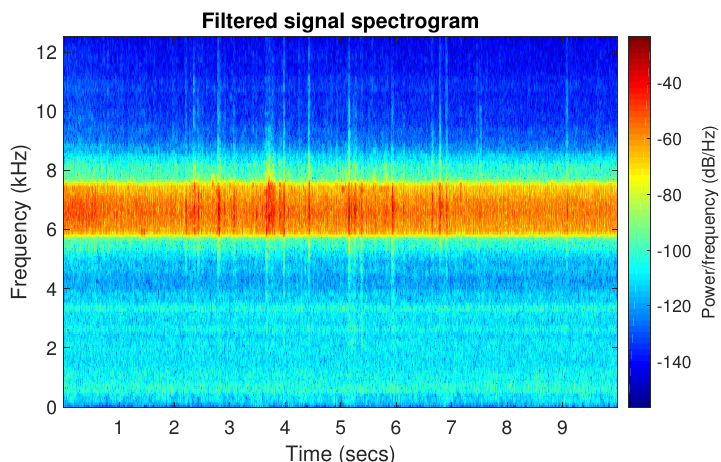
Figure 47. Spectrogram of filtered signal r by Spearman selector.